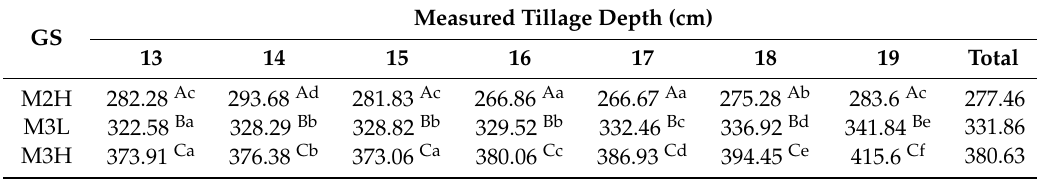
Table 7. Mean engine torque (Nm) according to the tillage depth and gear selection